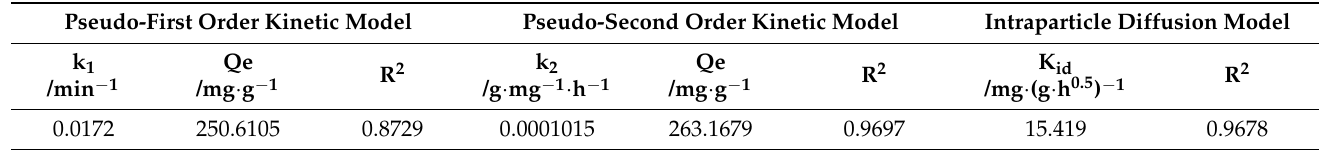
Figure 6. Fitting curves of ( a ) Pseudo-first order and ( b ) Pseudo-second order kinetic models, and ( c ) intra-particle diffusion model for adsorption of Pb(II) on CSH. Table 3. Fitting parameter of Pseudo-first order and Pseudo-second order kinetic models and intra-particle diffusion model for adsorption of Pb(II) on CSH .